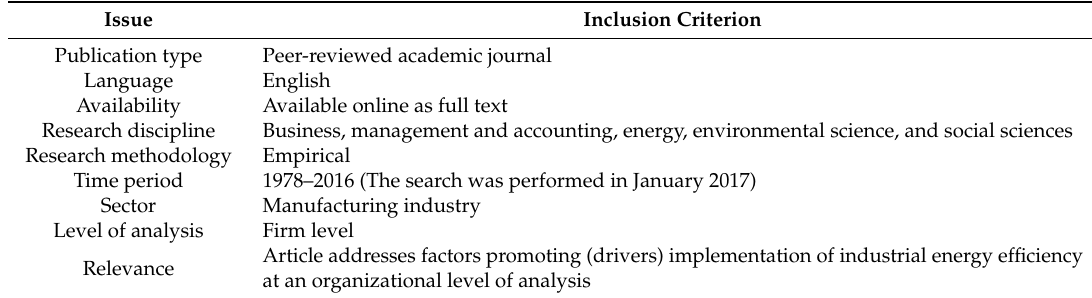
Table 1. Selection criteria of the systematic literature